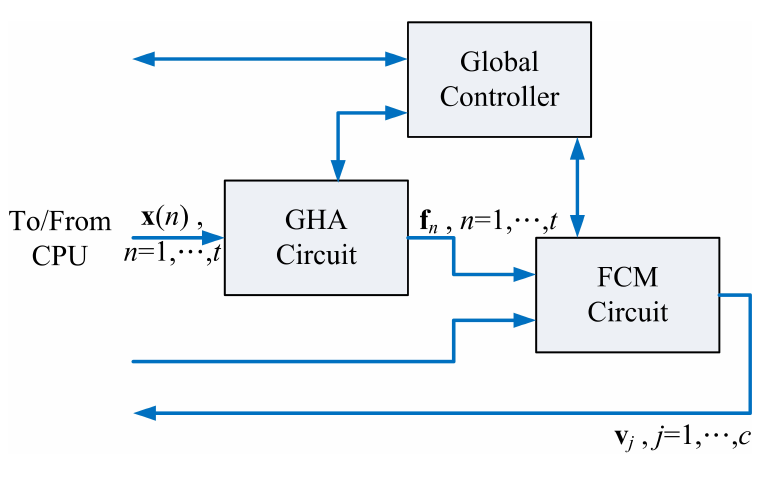
Figure 1. The proposed spike sorting